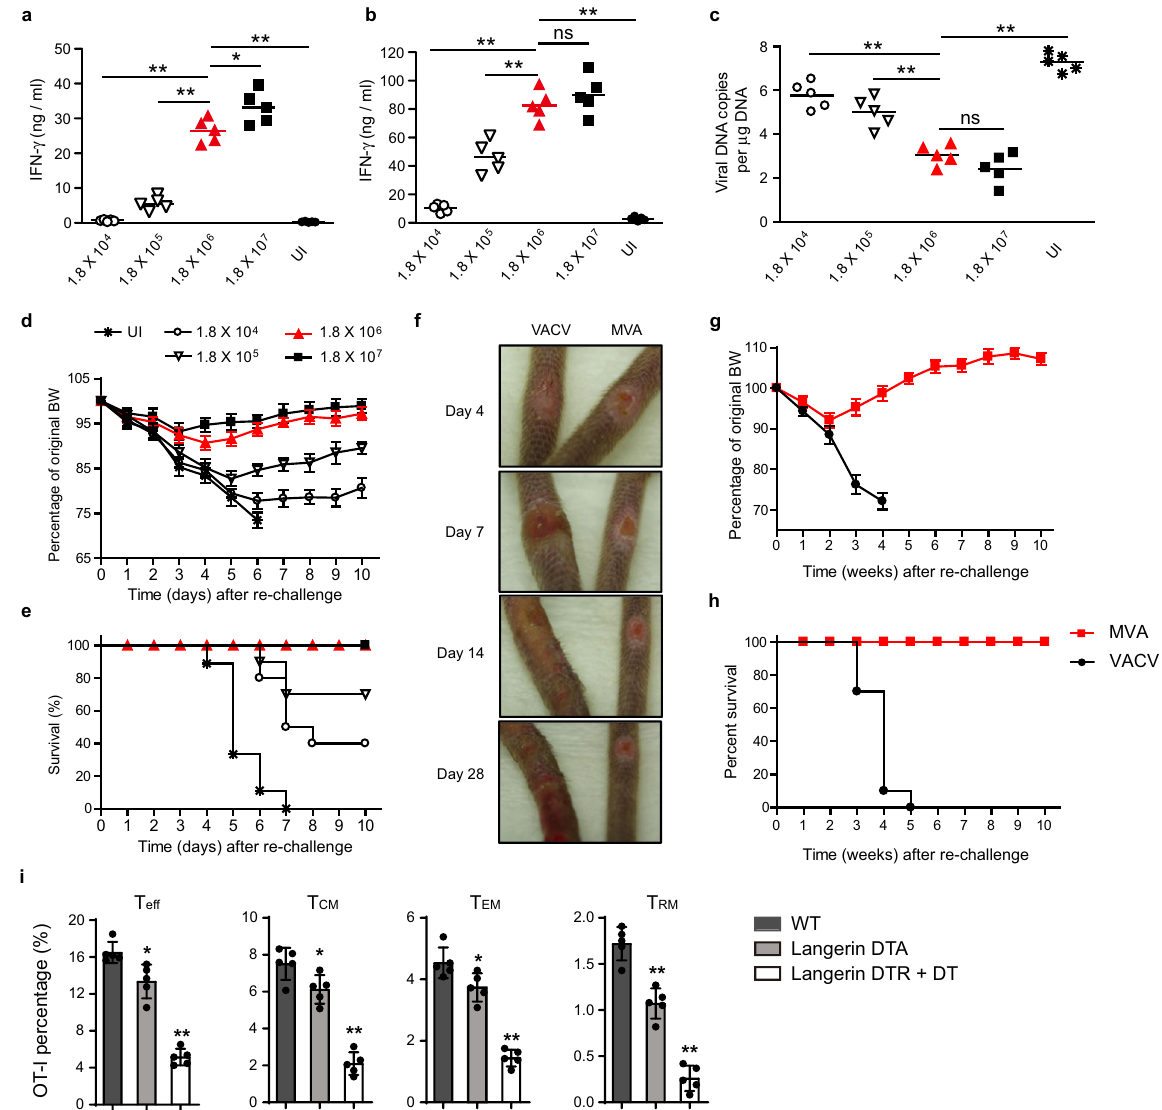
Fig. 1 MVA immunization via skin scari fi cation (s.s.) elicits dose-dependent anti-VACV immune response. a , b IFN- γ secretion by vaccinia- speci fi c T cells isolated from draining lymph nodes ( a ) or spleens ( b ) at 7 days post MVA infection at indicated dose. c Quantitative real-time PCR (qRT-PCR) analysis of skin viral load at 6 days post re-infection. Mice were immunized with the indicated doses of MVA via s.s. 45 days later, mice were re-challenged with 1.8 × 10 6 pfu vaccinia virus (VACV). Then 6 days later, skin tissues were collected and processed to qRT-PCR. d , e Body weight (BW) ( d ) and survival measurements ( e ) of WR-VACV re-challenged mice that were immunized previously with MVA at indicated dose 45 days earlier. f Photographs of pox lesion in Rag1 − / − mice taken on day 4, 7, 14, and 28 post immunization with the same amount (1.8 × 10 6 pfu) of MVA or VACV. g , h Immunized Rag1 − / − mice were monitored for BW change ( g ) and survival ( h ) for up to 12 weeks after immunization with the same amount (1.8 × 10 6 pfu) of MVA or VACV. i Quanti fi cation of effector T cell (T eff , day 5), central memory (T CM , day 45), effector memory (T EM , day 45), or tissue resident memory (T RM , day 45) T cells post MVA infection. Naive OT-I Thy1.1 + cells were transferred into Thy1.2 + recipient mice 1 day before mice were infected with 1.8 × 10 6 pfu MVA-Ova. Then, at different time points post infection, OT-I cells were isolated from the lymph nodes (T eff , T CM , T EM ) or skin (T RM ) and analyzed by fl ow cytometry. a – c Data are representative of three independent experiments. Symbols represent individual mice ( n = 5 mice/group). a – d Unimmunized (UI) mice were included as controls. Graphs show mean ± SD ( n = 5), ns = not signi fi cant, * p < 0.05, ** p < assayed 45 days after initial vaccination were subjected to intranasal challenge, and mice were weighed daily after vaccina- tion. Mice that lost >20% of body weight (BW) were killed. Figure 3g, h show that naive mice universally succumbed to the lethal infection, whereas mice immunized s.s. showed minor transient weight loss but complete survival. In contrast, mice vaccinated i.d.,